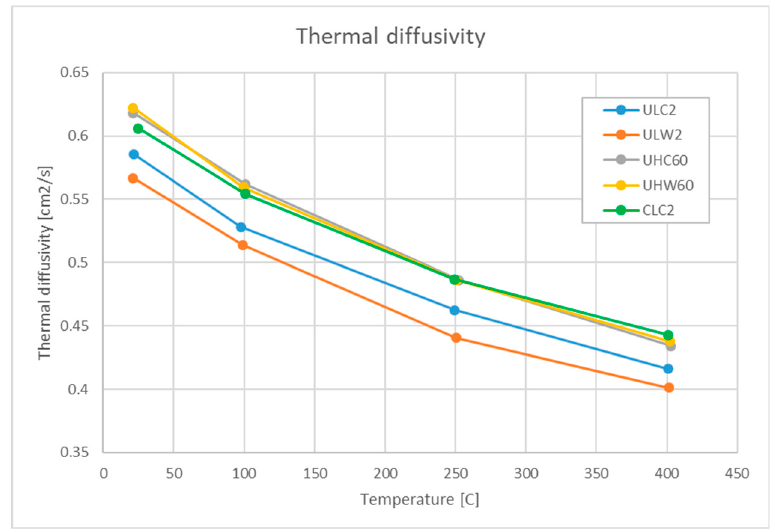
Figure 12. Temperature dependence of thermal diffusivity of the ULC2, ULW2, UHC60, UHW60 and CLC2 samples.